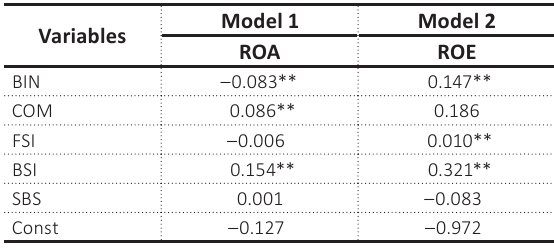
Table 9. Multiple regression